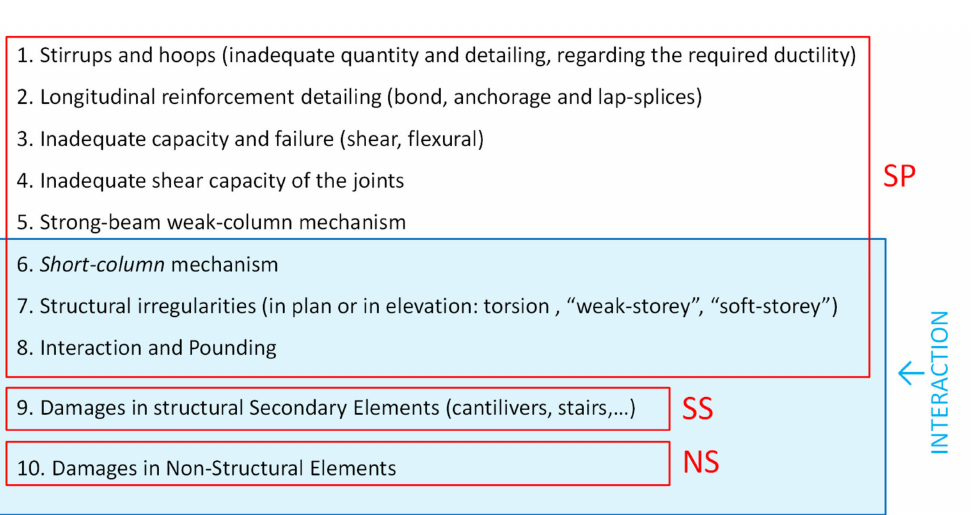
Figure 2. Types of damage in infilled RC frames when subjected to earthquakes.